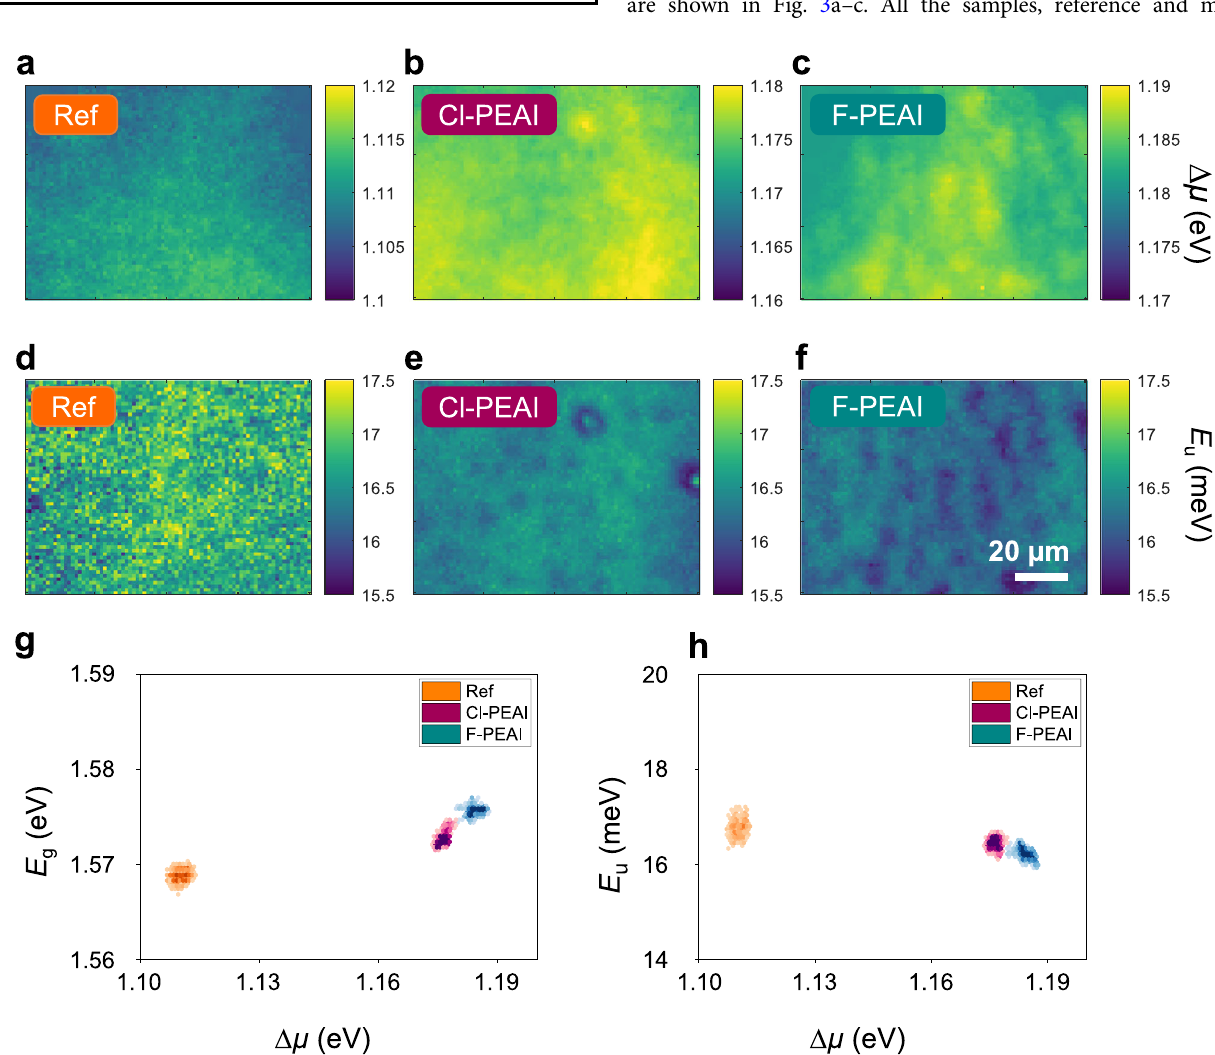
Fig. 3 Continuous wave photoluminescence imaging analysis. Hyperspectral measurements on the stack glass/ITO/PTAA/perovskite/BCP/PCBM. quasi-Fermi level splitting ( Δ µ ) maps for a reference sample, b Cl-PEAI and c F-PEAI samples. Urbach Energy maps for d reference sample, e Cl-PEAI and f F-PEAI samples. g Correlation between energy gap and QFLS. h correlation between Urbach Energy and QFLS. The scalebar applies to all